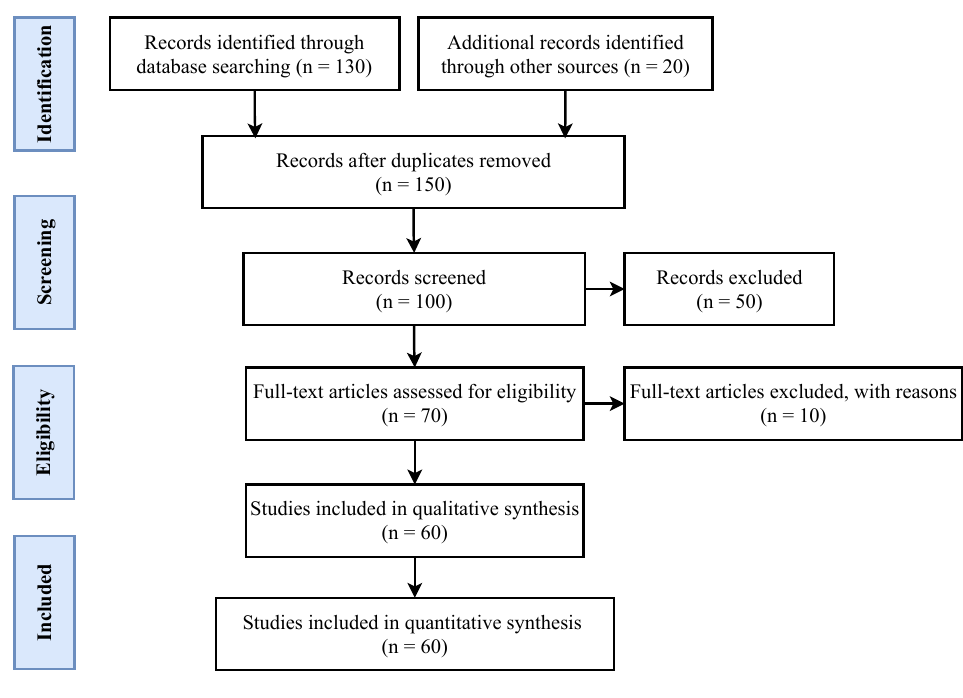
Figure 2. Flow chart of paper selection